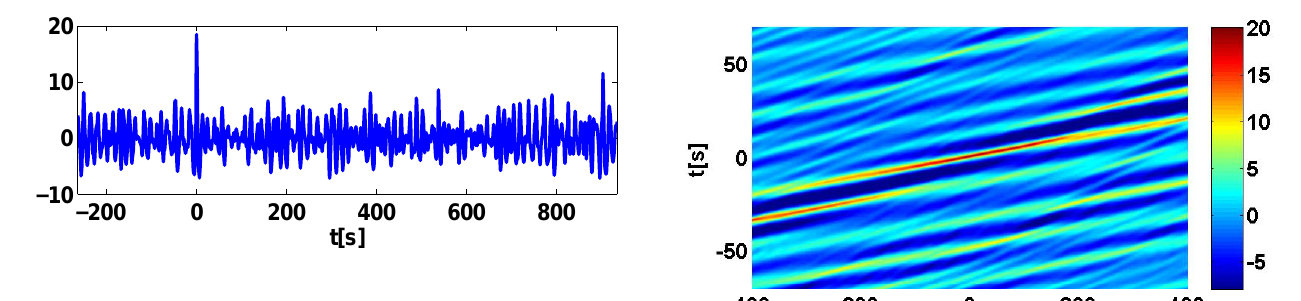
Fig. 12. The Draupner signal, with time of highest wave crest put